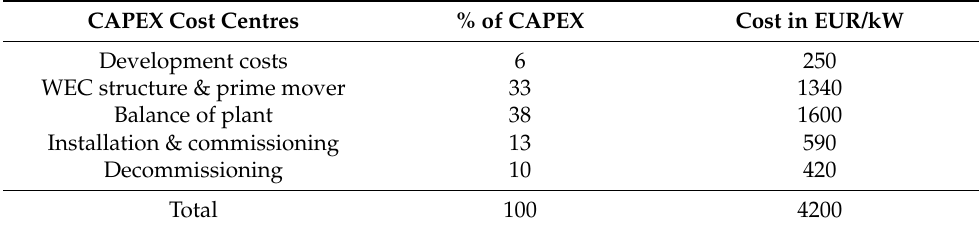
Table 6. Breakdown of costs for the mid-term project (TRL 2), assuming a CAPEX value of 4200 EUR/kW targetting the LCOE of 200 EUR/MWh.